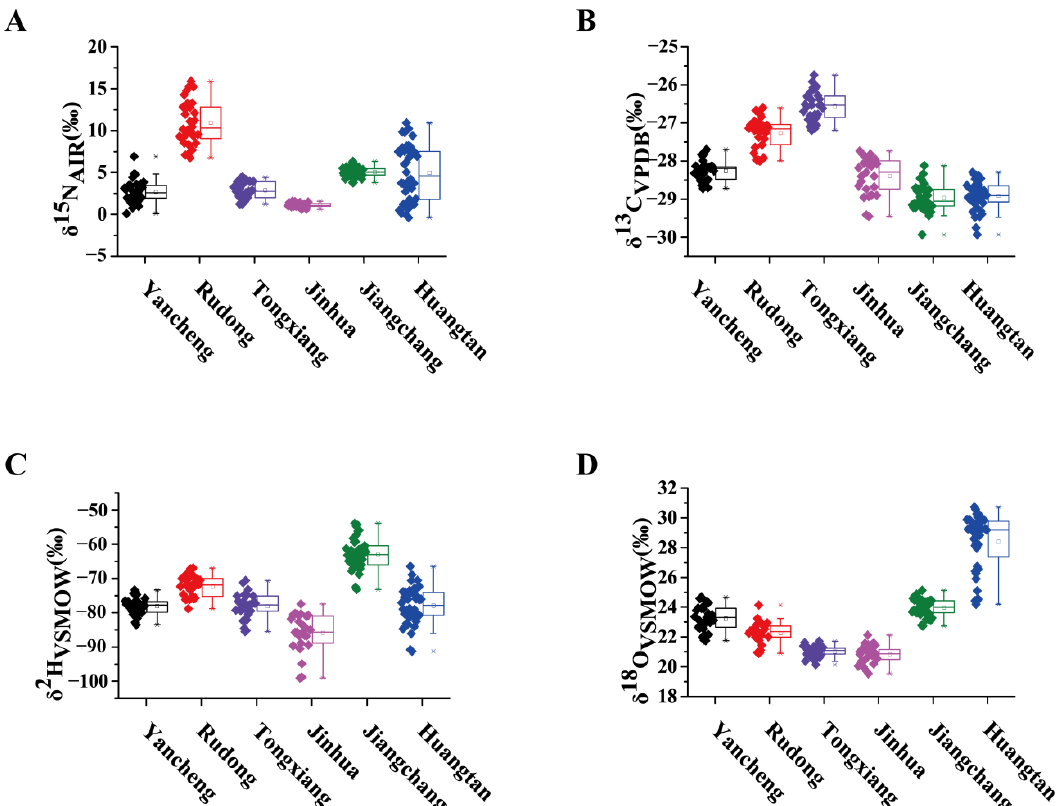
Figure 2. Box diagrams of ( A ) δ 15 N, ( B ) δ 13 C, ( C ) δ 2 H, and ( D ) δ 18 O samples from six different regions of China, respectively. Table 1. Mean values of N, C, H, and O stable isotopes of HBJ flower from different origins.